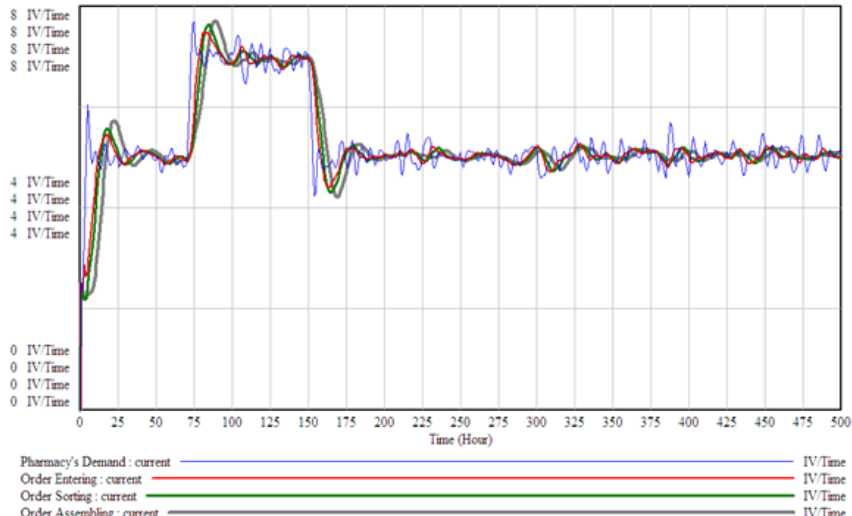
Figure 12. Pharmacy’s demand and processing